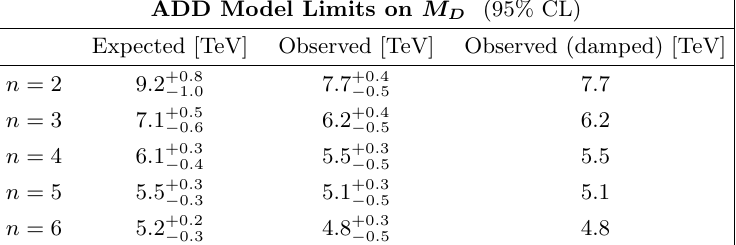
Table 7 . The 95% CL observed and expected lower limits on the fundamental Planck scale in 4 + n dimensions, M D , as a function of the number of extra dimensions n , considering nominal LO signal cross sections. The impact of the (cid:6) 1 (cid:27) theoretical uncertainty on the observed limits and the expected (cid:6) 1 (cid:27) range of limits in the absence of a signal are also given. Finally, the 95% CL observed limits after damping of the signal cross section for ^ s > M 2 (see text) are D